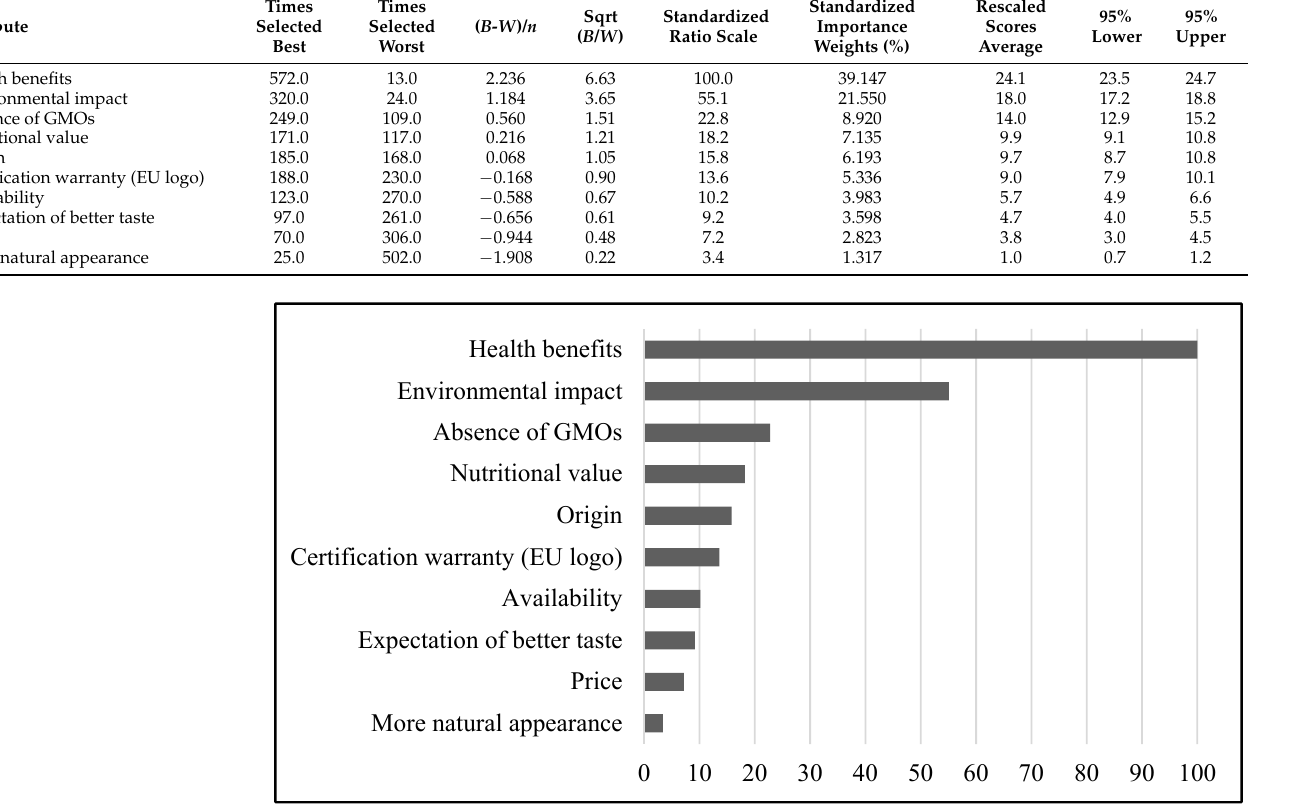
Figure 2. The ten organic attributes presented as standardized ratio scale.